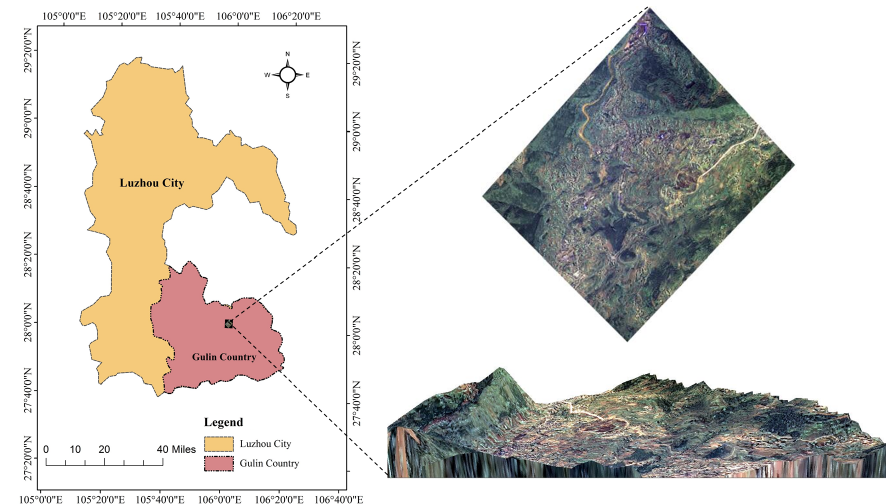
Figure 1. Location of study area and 3D representation of remote sensing image.